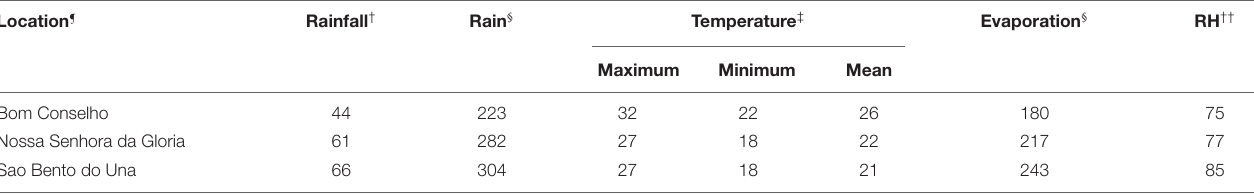
TABLE 1 | Meteorological data during the experimental period for the selected locations. Location